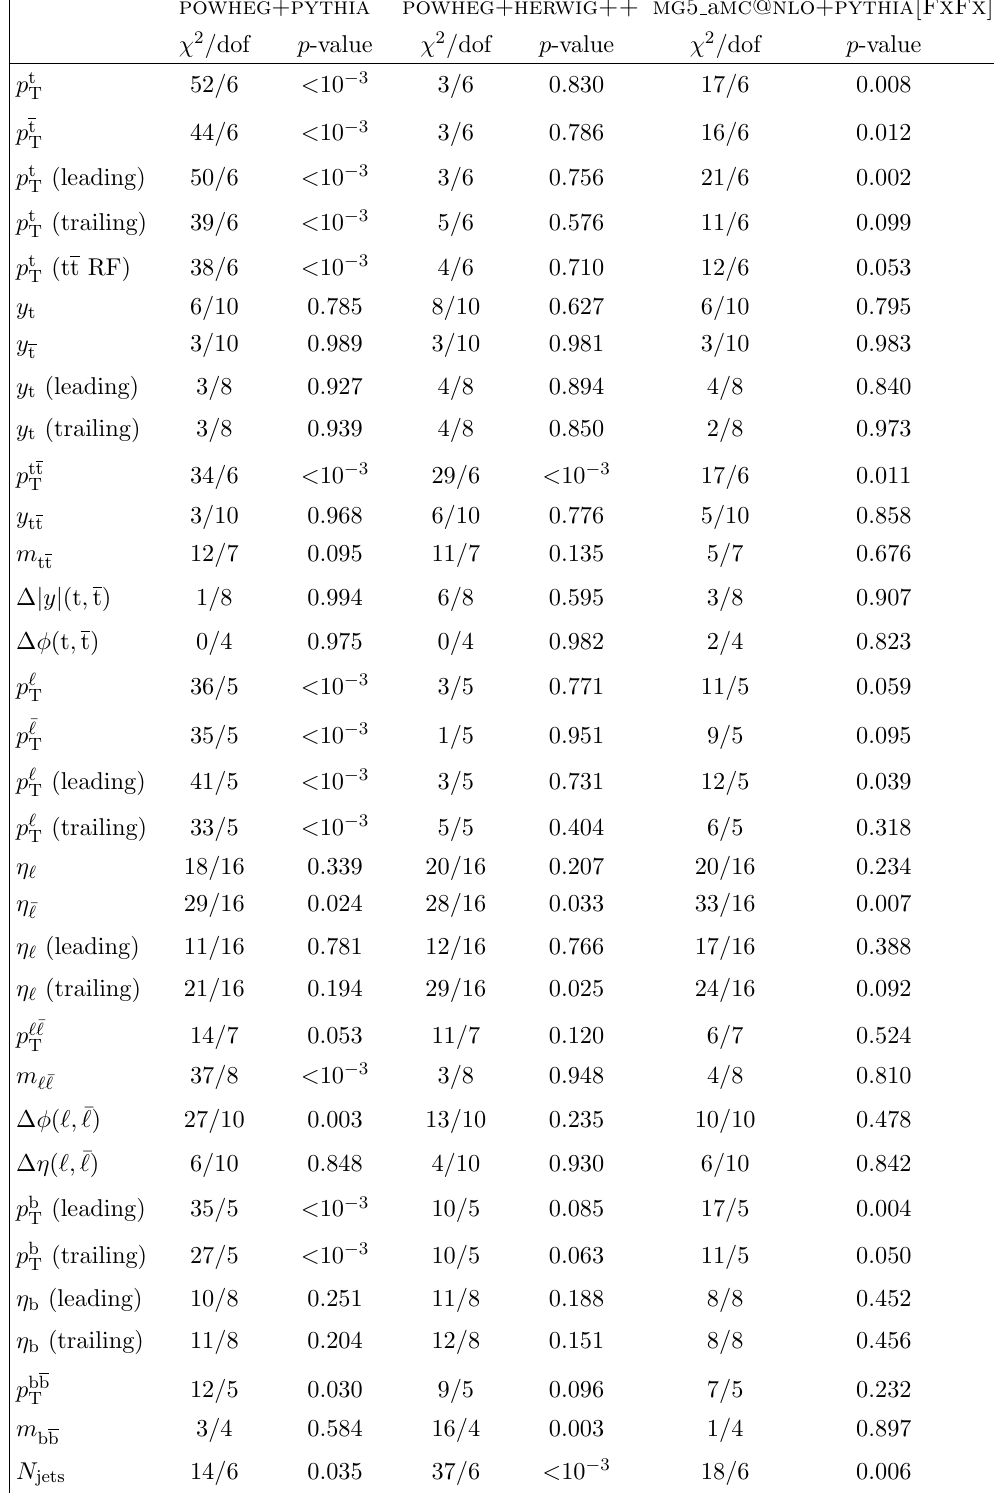
Table 55 . The (cid:31) 2 /dof and p -values quantifying the agreement between the three MC predictions and the measured, particle-level absolute cross sections are